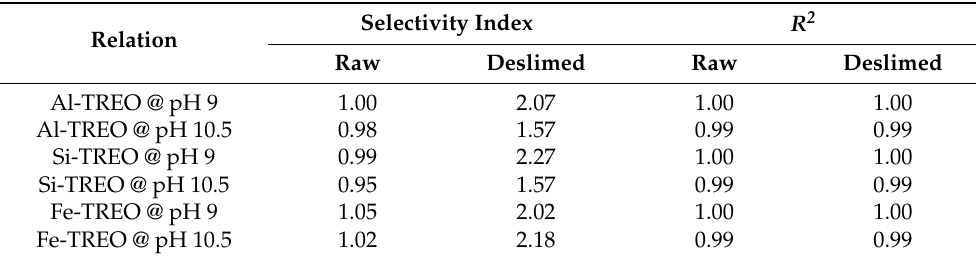
Figure 11. TREO ( a ) Al, ( b ) Si, and ( c ) Fe species selectivity analyses. R 2 values obtained in all the analyses were ~1, demonstrating good reliance of the data obtained from the plots. Table 8. Summary of REE–gangue species selectivity